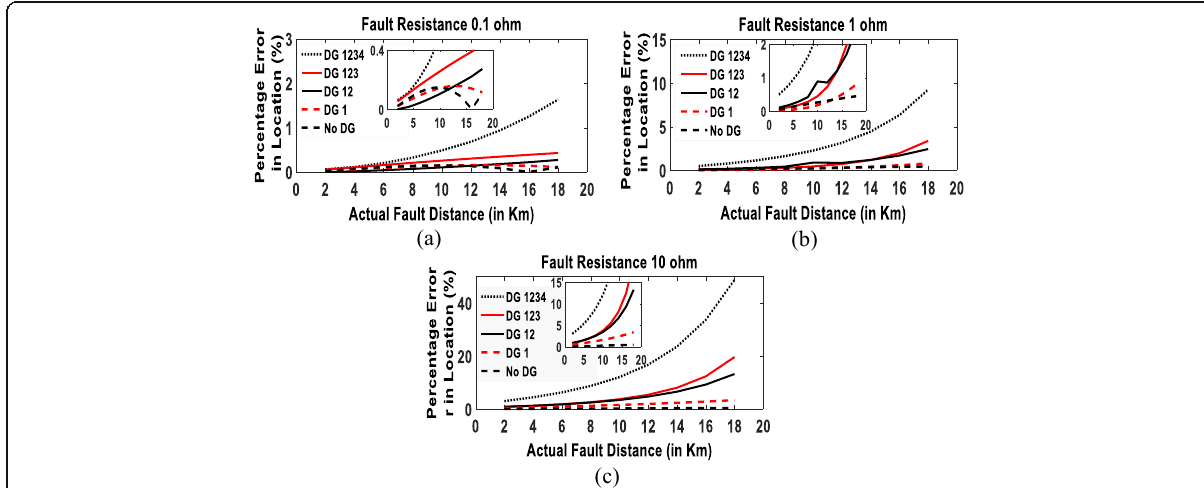
Fig. 7 Comparison of the percentage error in fault location (%) evaluated by the proposed fault location algorithm for single phase to ground fault (a-g) at different fault locations (2 Km to 18 Km i.e., FDR varied from 0.1 to 0.9 p.u., respectively), on the distribution line DLAB in the micro grid operating under grid connected mode, subjected to various levels of DG penetrations, where ( a ) response for fault resistance (Rf =) 0.1 Ω , ( b ) response for fault resistance (Rf) = 1 Ω , and ( c ) response for fault resistance (Rf) = 10 Ω ,